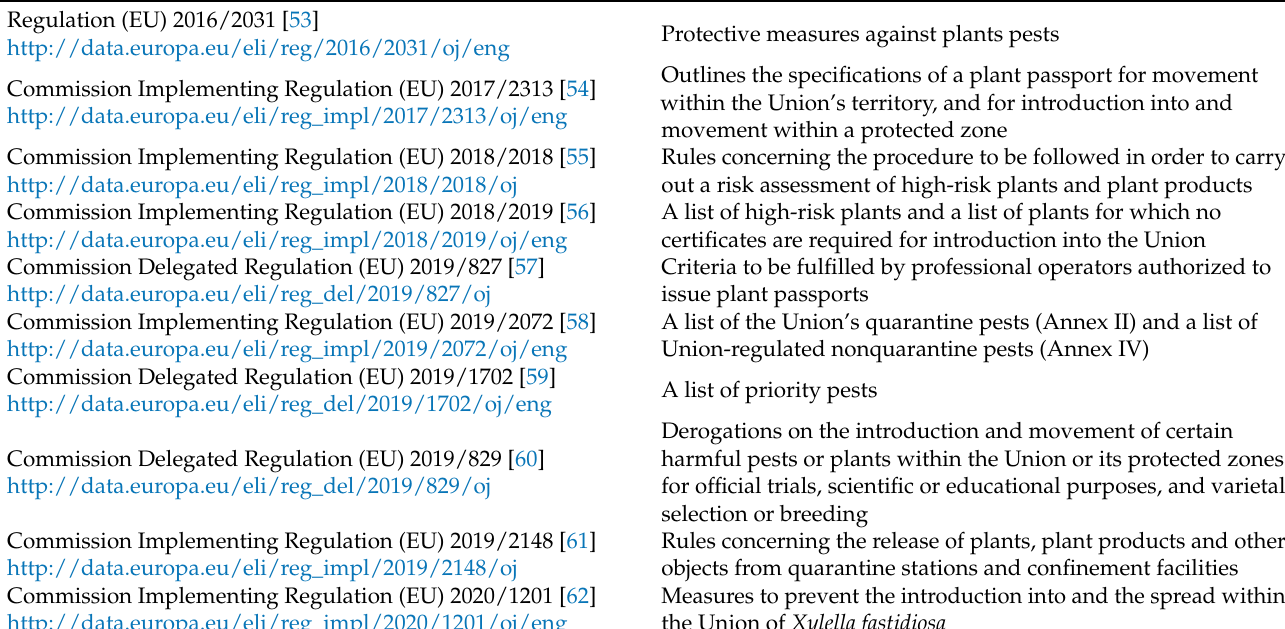
Table 1. European regulatory framework in force on the prevention of the entry and spread of plant pests in the territory of the European